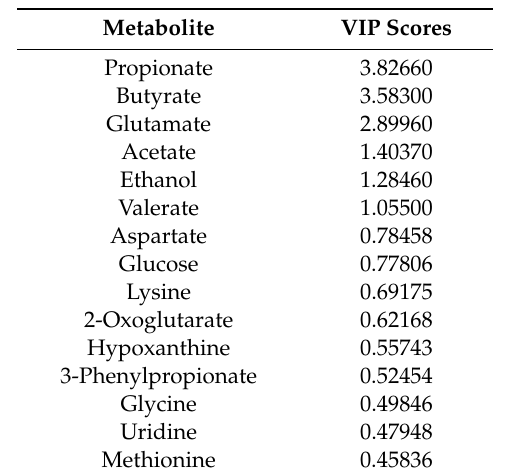
Table 3. The VIP scores of THR100 and THR125 for partial least squares discrimination analysis (PLS-DA).